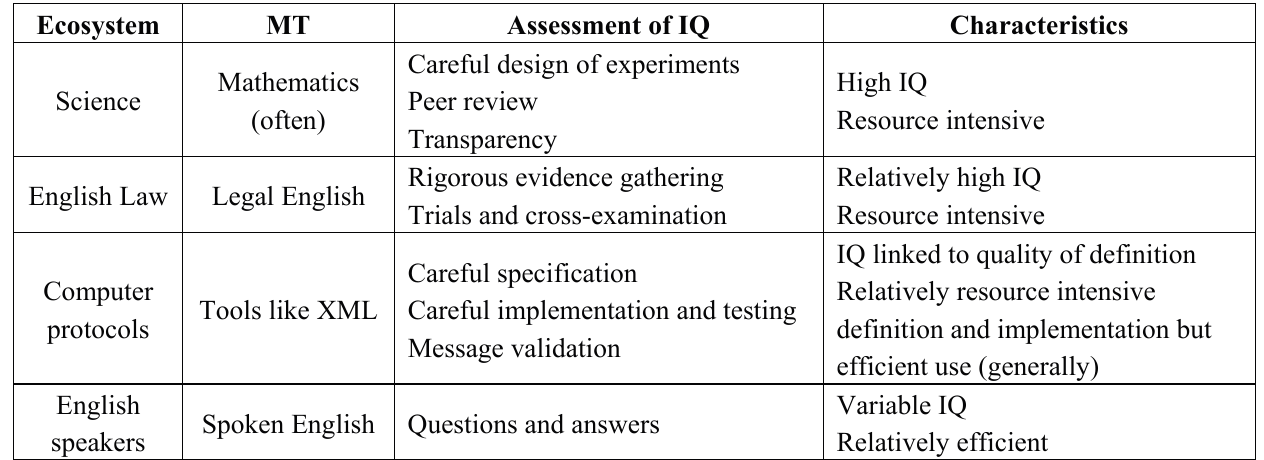
Table 5 . Assessing IQ—some